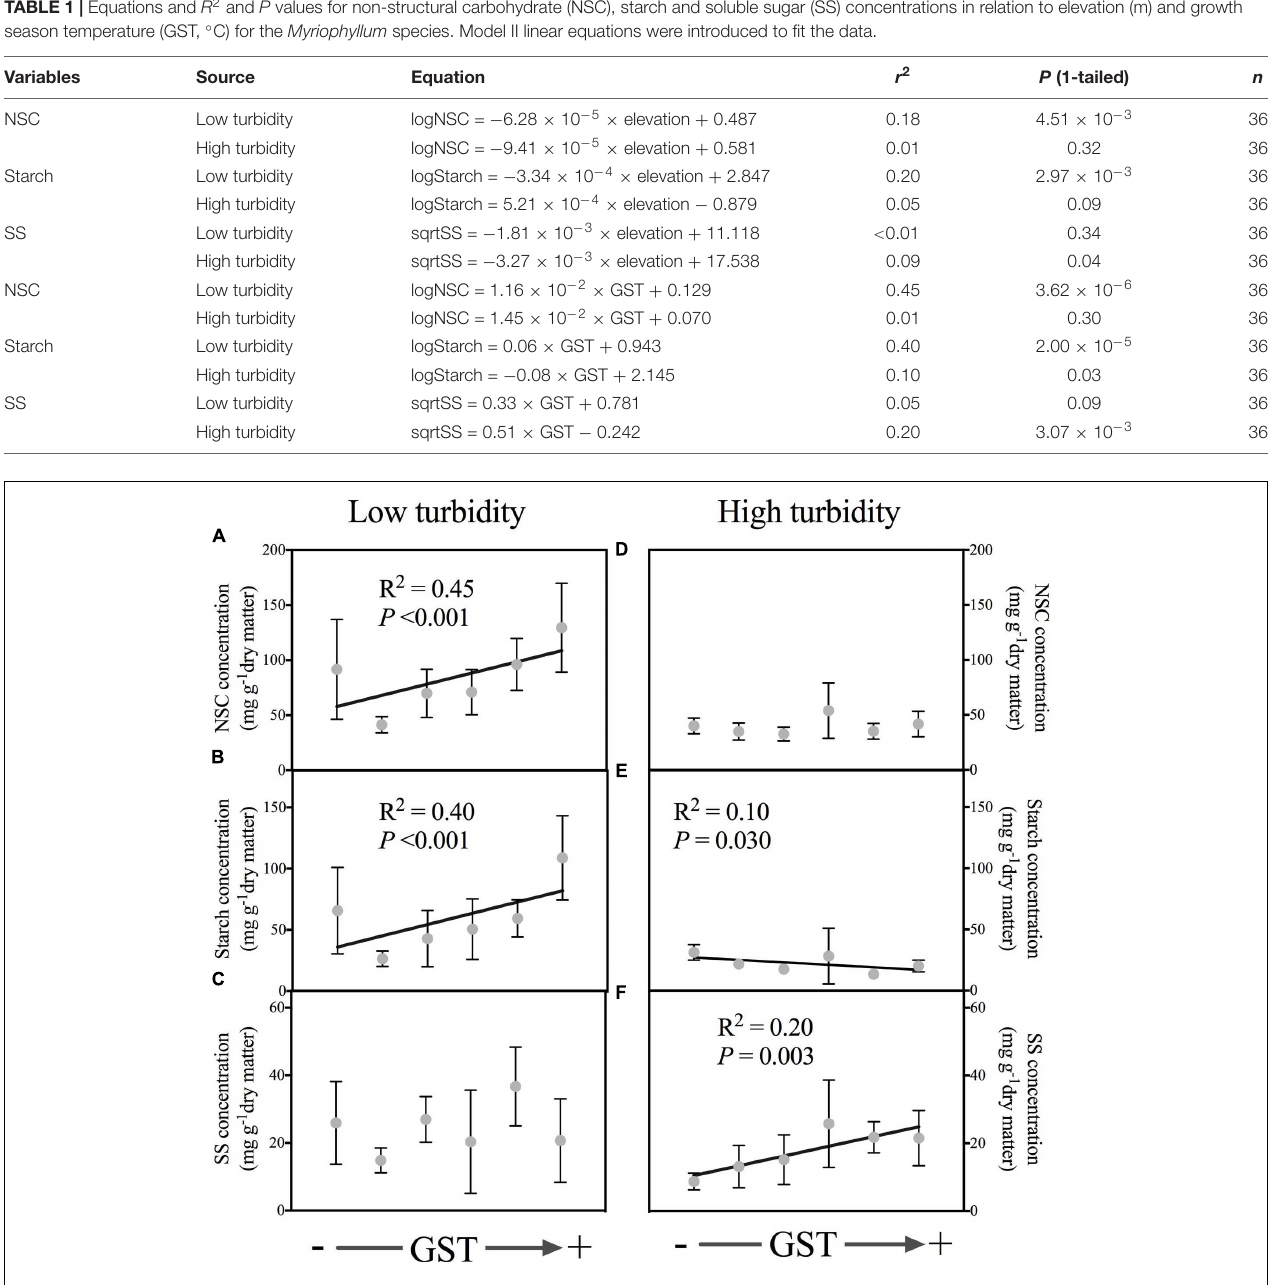
FIGURE 3 | Relationships of the non-structural carbohydrate (NSC), starch and SS (soluble sugars) of leaves to mean annual temperature (GST, ◦ C) in low turbidity ( < 3.97 NTU, A–C , including five water bodies) and high turbidity ( > 3.97 NTU, D–F , including seven water bodies) sampled water bodies, respectively. In